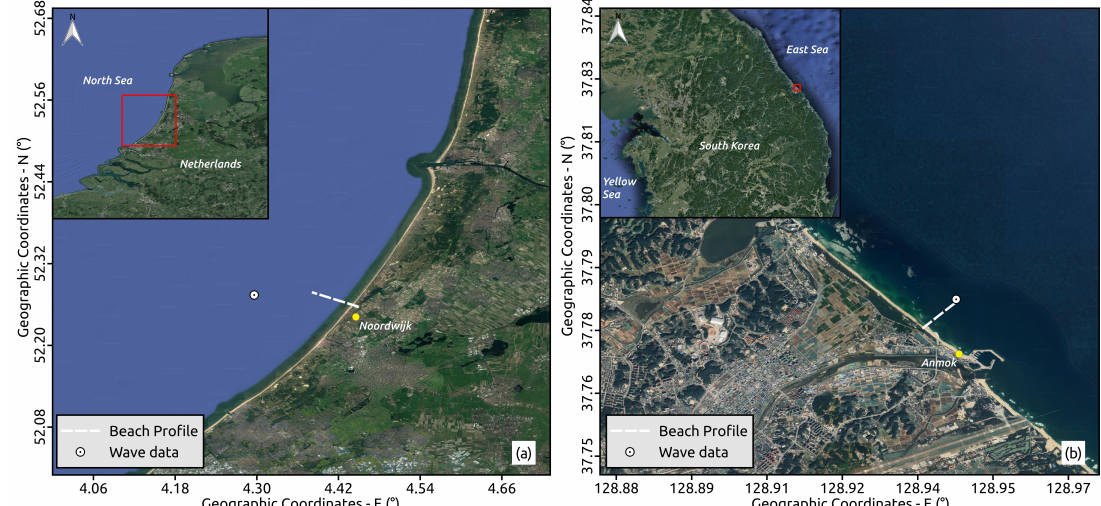
Figure 1. Location of the simulated beach profile and the wave observations used as forcing of the models of the study area, Noordwijk, the Netherlands ( a ) and the validation area, Anmok, South Korea ( b ). Map data: Google.